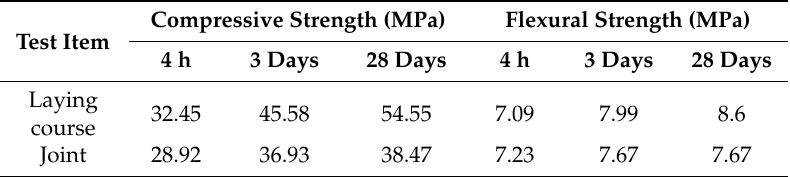
Table 4. Test outcome of mortar for laying course and joint (Han and Gong et al. [3]).